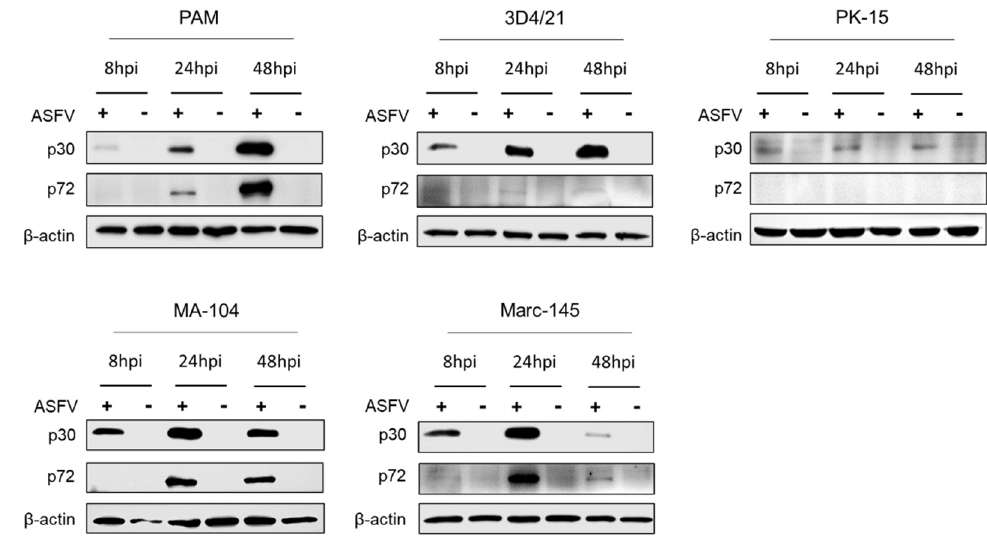
Figure 5. ASFV early and late genes expressions in PAMs, 3D4/21, PK-15, MA-104 and Marc-145 cells. The cells were infected with ASFV at 5 MOI for 2 h at 37 °C. After washing with PBS three times, and incubation with fresh medium, the cells lysates were collected at 8, 24 and 48 hpi, and ASFV p30 and p72 protein expressions were detected by western blot. +: ASFV infected; − : mock.